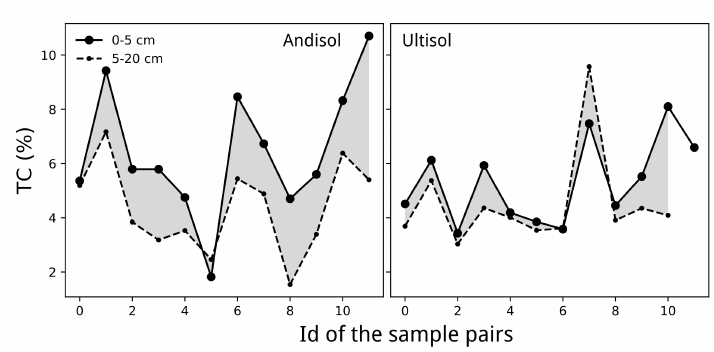
Figure 5. Total carbon (TC) in the Andisol and Ultisol soil orders. The gray area represents the difference in soil TC of the two